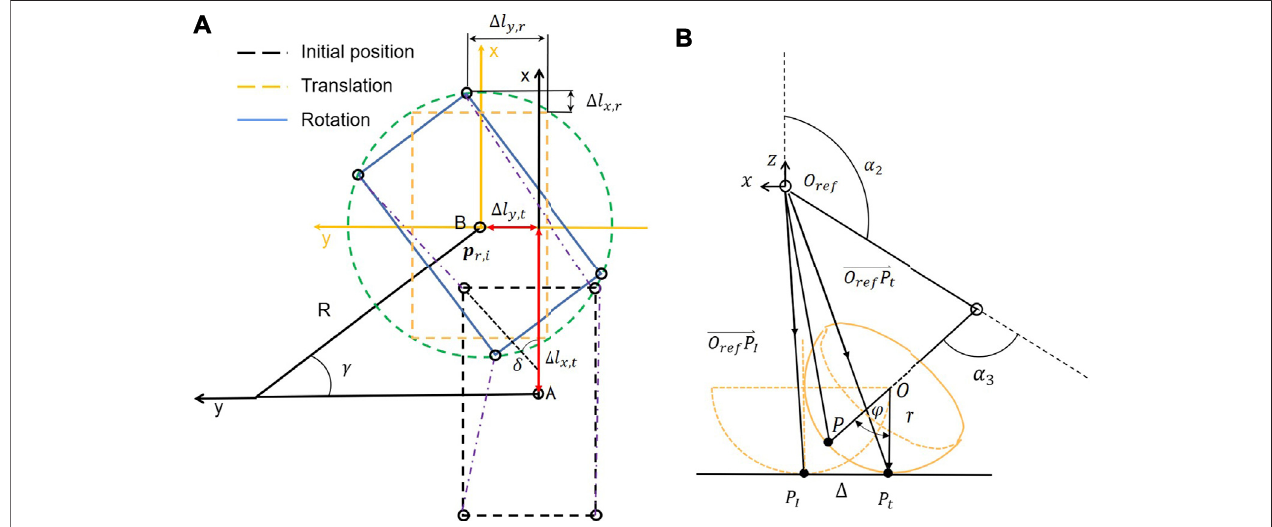
FIGURE 3 | (A) Transformation process of the circling/spinning gait divided into translation and rotation. (B) The inverse kinematics for a leg with a spherical foot- end effector that rolls on ground during the support phase.